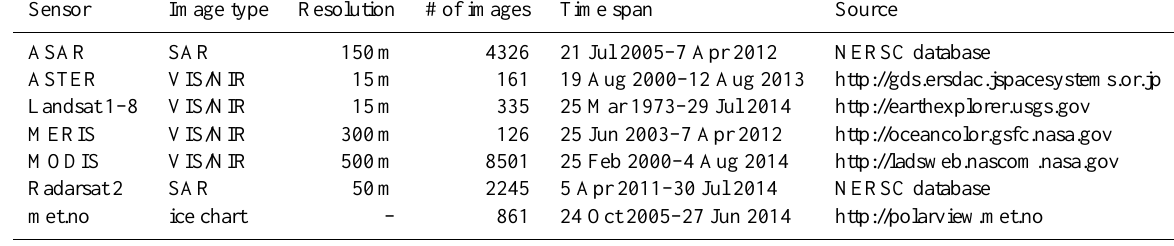
Table 1. Satellite databases used, including sensor, image type, spatial resolution (i.e. pixel size), amount of collected images, covered time span (i.e. date of first and last image) and source.